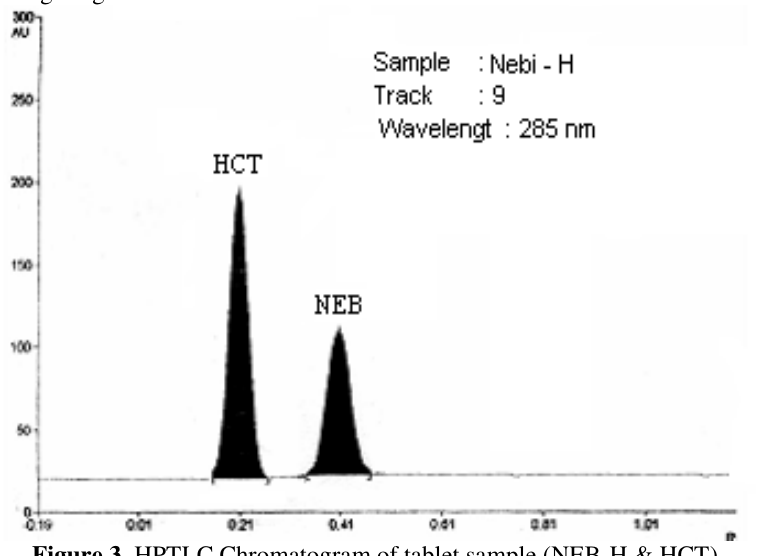
Figure 3. HPTLC Chromatogram of tablet sample (NEB-H & HCT)